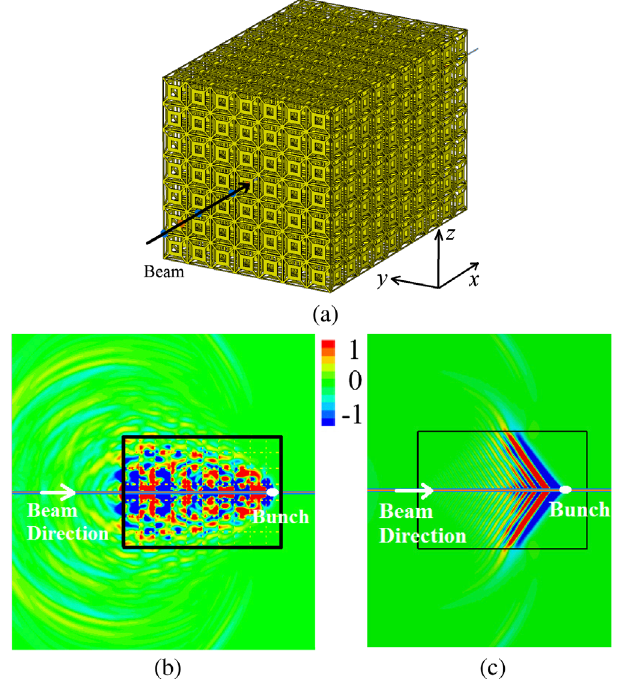
FIG. 6. Radiation pattern with a relativistic beam. (a) Illustration of the bulk structure. The beam passes through the line of y ¼ z ¼ 0 . (b) Longitudinal E field ( E y ¼ 0 middle cutting x ) on plane for the MTM structure. The MTM region is enclosed in the black rectangles. (c) The same result for the volume mode of a dielectric with ε ¼ 1 . 5 .